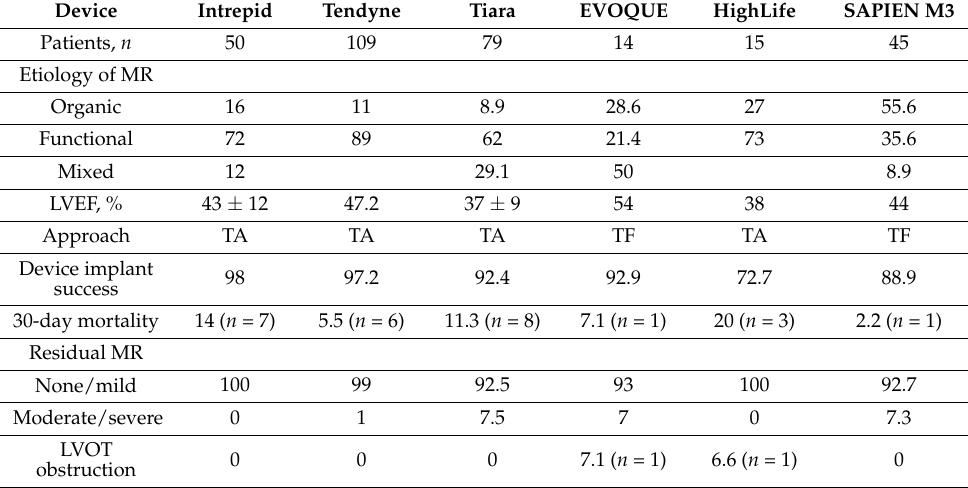
Table 2. Transcatheter mitral valve replacement